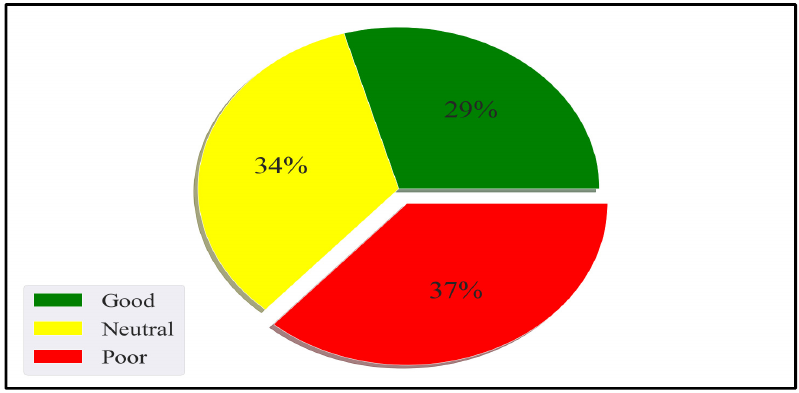
Figure 24. Heart rate class distribution ( n = 6).